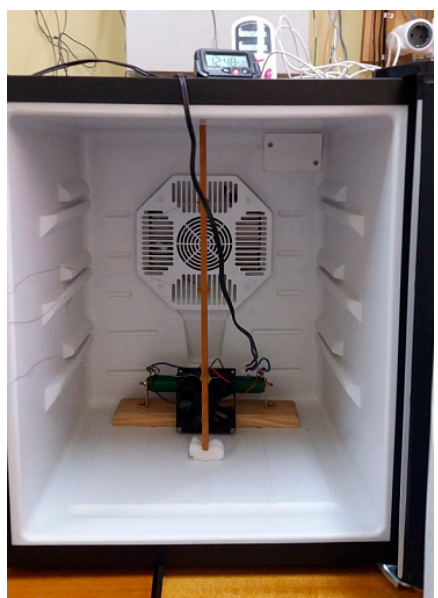
Figure 2. A simplified schematic diagram of the test stand for measuring the k coefficient of thermoelectric refrigerators.